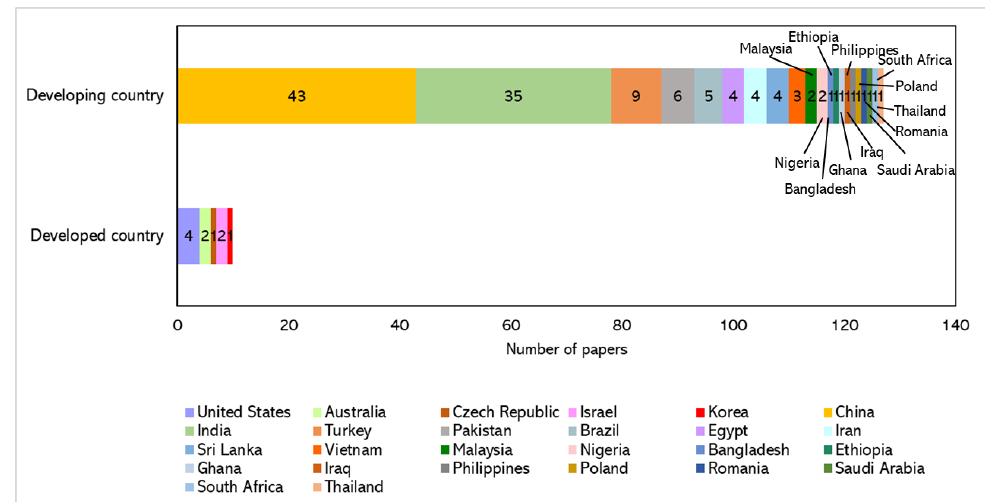
Figure 5. The number of studies that focused on cities in developed and developing nations.